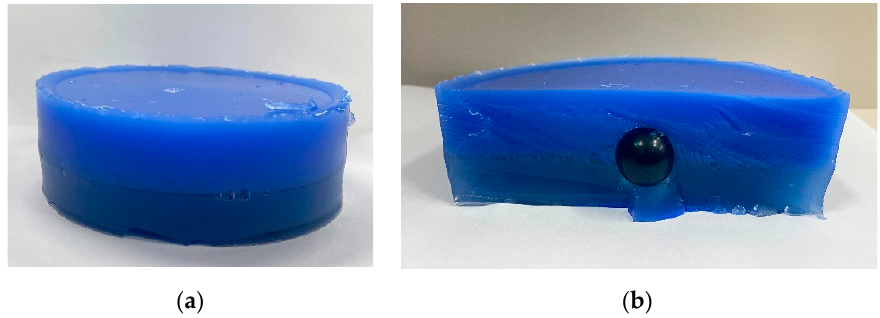
Figure 14. ( a ) Human phantom. ( b ) Cross-sectional view of the phantom.